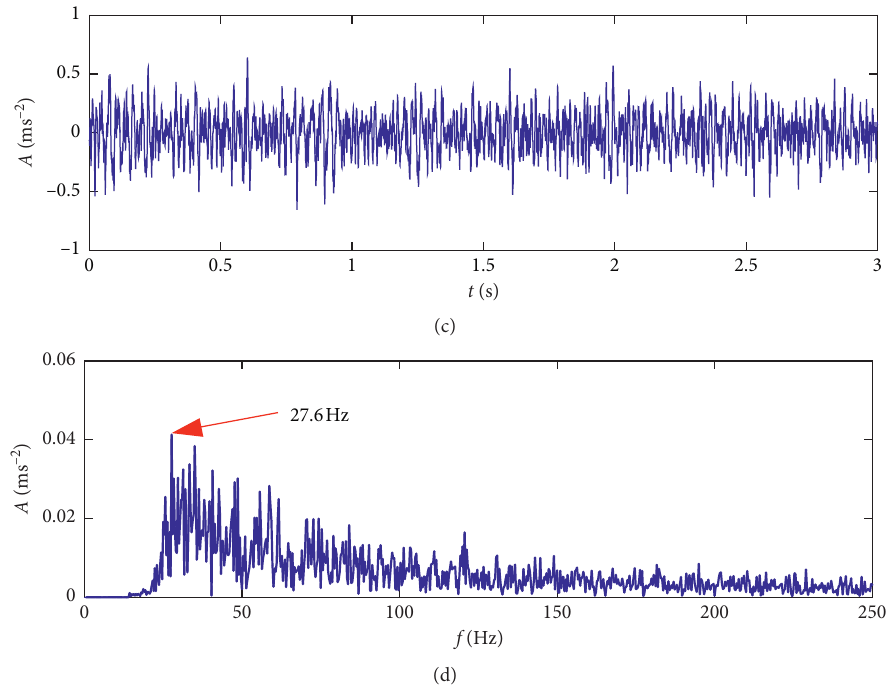
Figure 10: The results of the TFMSR method: (a) time domain waveform of the original signal; (b) spectrum. The results of the CBSR method: (c) time domain waveform of the original signal; (d) spectrum.